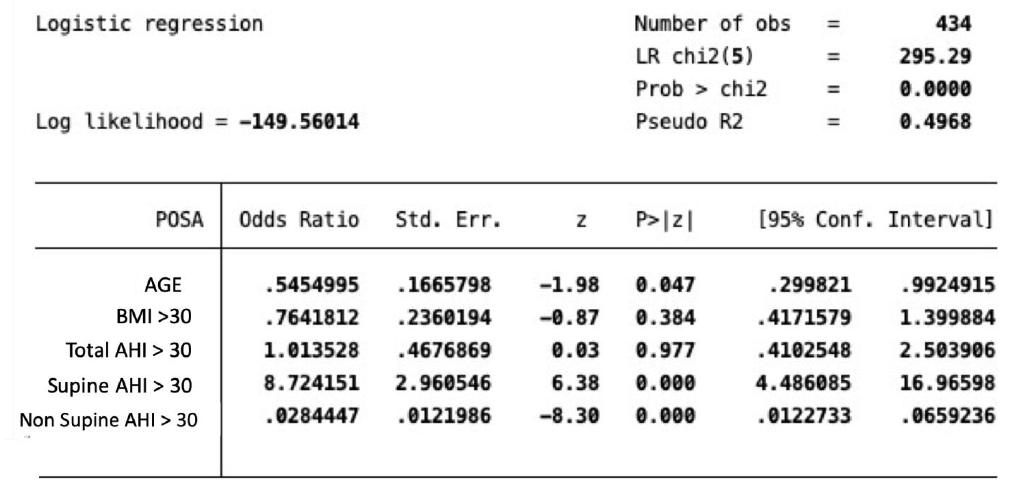
Figure 1. Multi-variable analysis of possible risk factors for